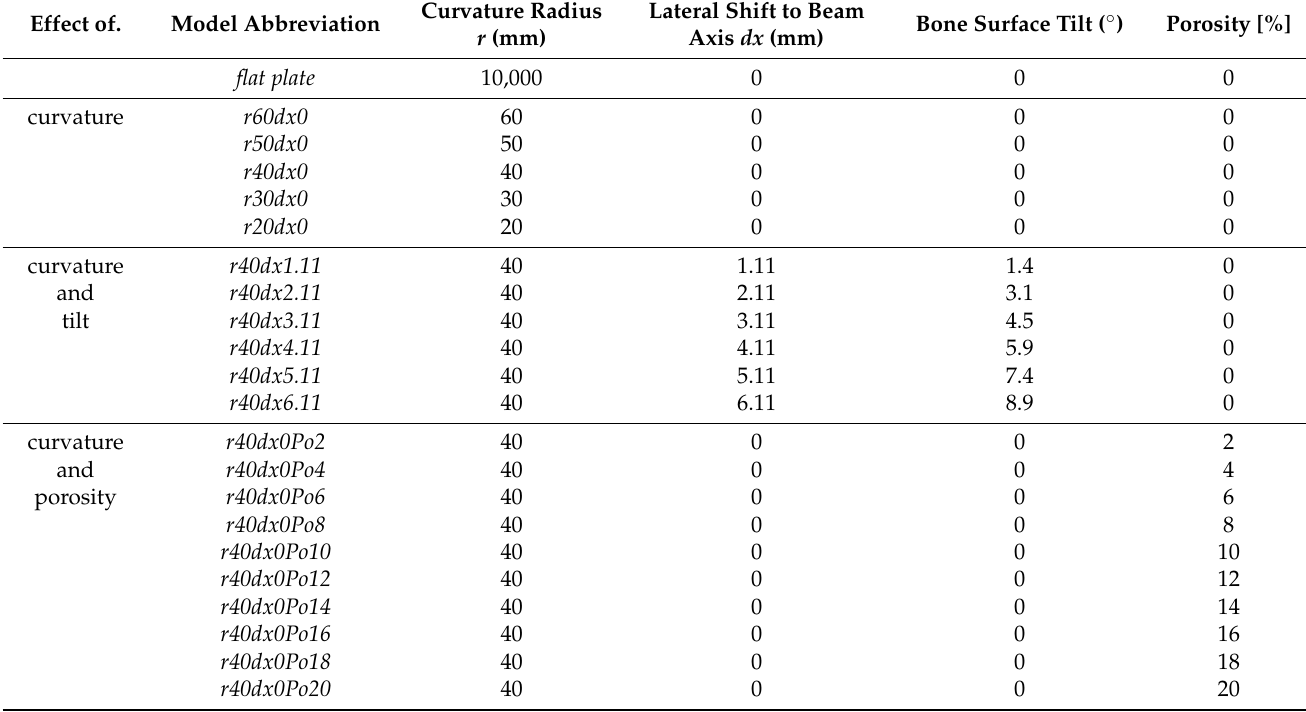
Table A2. Summary of simulation models. ‘ r ’ and ‘ dx ’ in the model abbreviations represent the curvature radius of the bone model and the lateral shift of the transmit and receive arrays relative to the beam axis, respectively. ‘ Po ’ represents the porosity value when pores were simulated. Effect